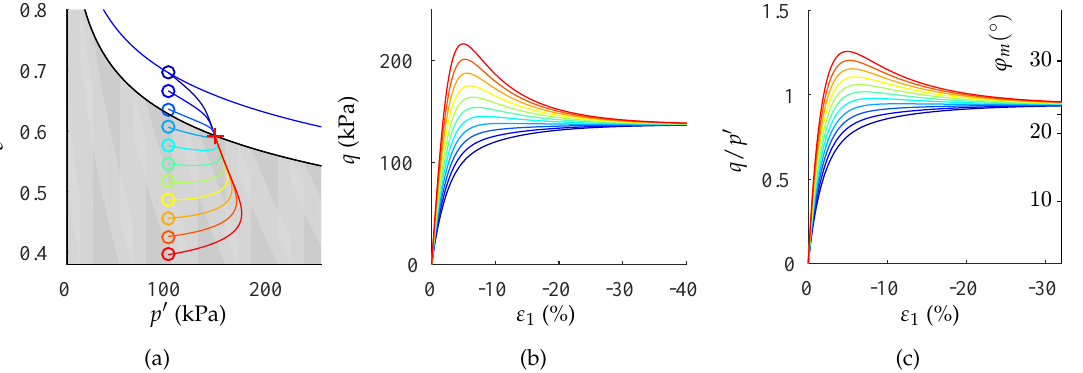
Figure 3. Pyknotropy in barodesy: simulations with barodesy of CD triaxial tests with Weald clay with = const. ( a ) mean stress - void ratio plot: highly overconsolidated samples (grayed area) dilate, p (cid:48) ini normally and slightly overconsolidated samples contract under shearing. ( b ) axial strain - deviatoric stress plot: the lower the initial void ratio is, the higher is peak strength. ( c ) axial strain - stress ratio plot: highly overconsolidated samples reach higher stress ratios/mobilized friction angles than the critical friction